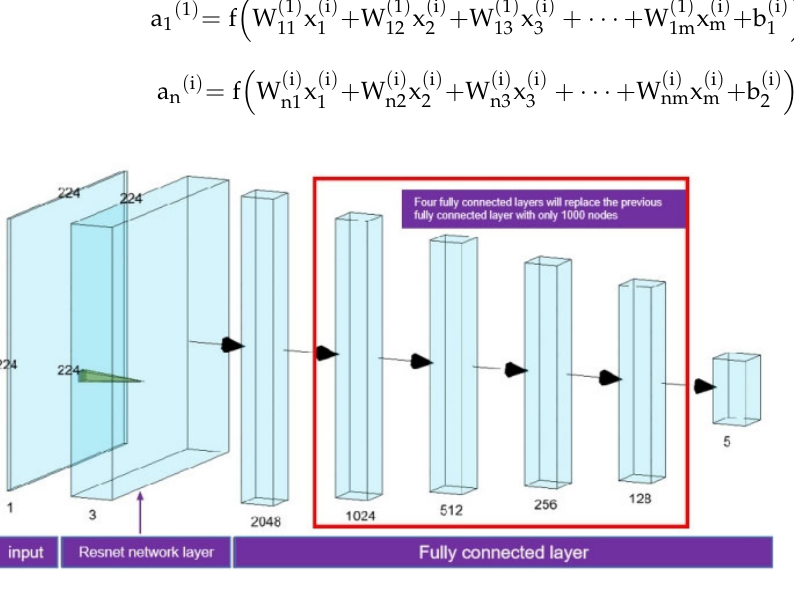
Figure 6. Schematic diagram of the ResNet 101 layer network structure after modification.